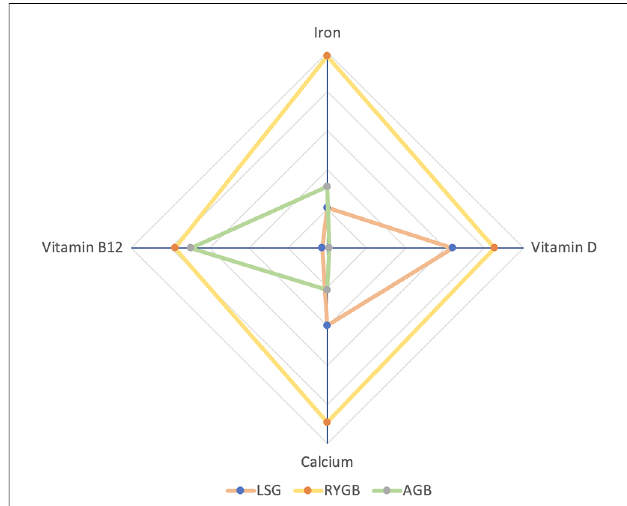
FIGURE 5 Rank-ordered radar chart: the farther from the center point is, the higher the probability of the corresponding